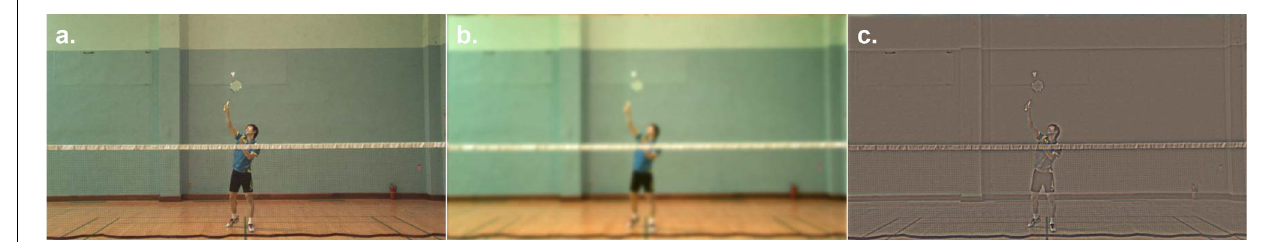
FIGURE 1 | Demonstration of each of the three spatial frequency stimuli used in the training intervention; (a) Normal-SF information, (b) low-SF information only, and (c) high-SF information only.